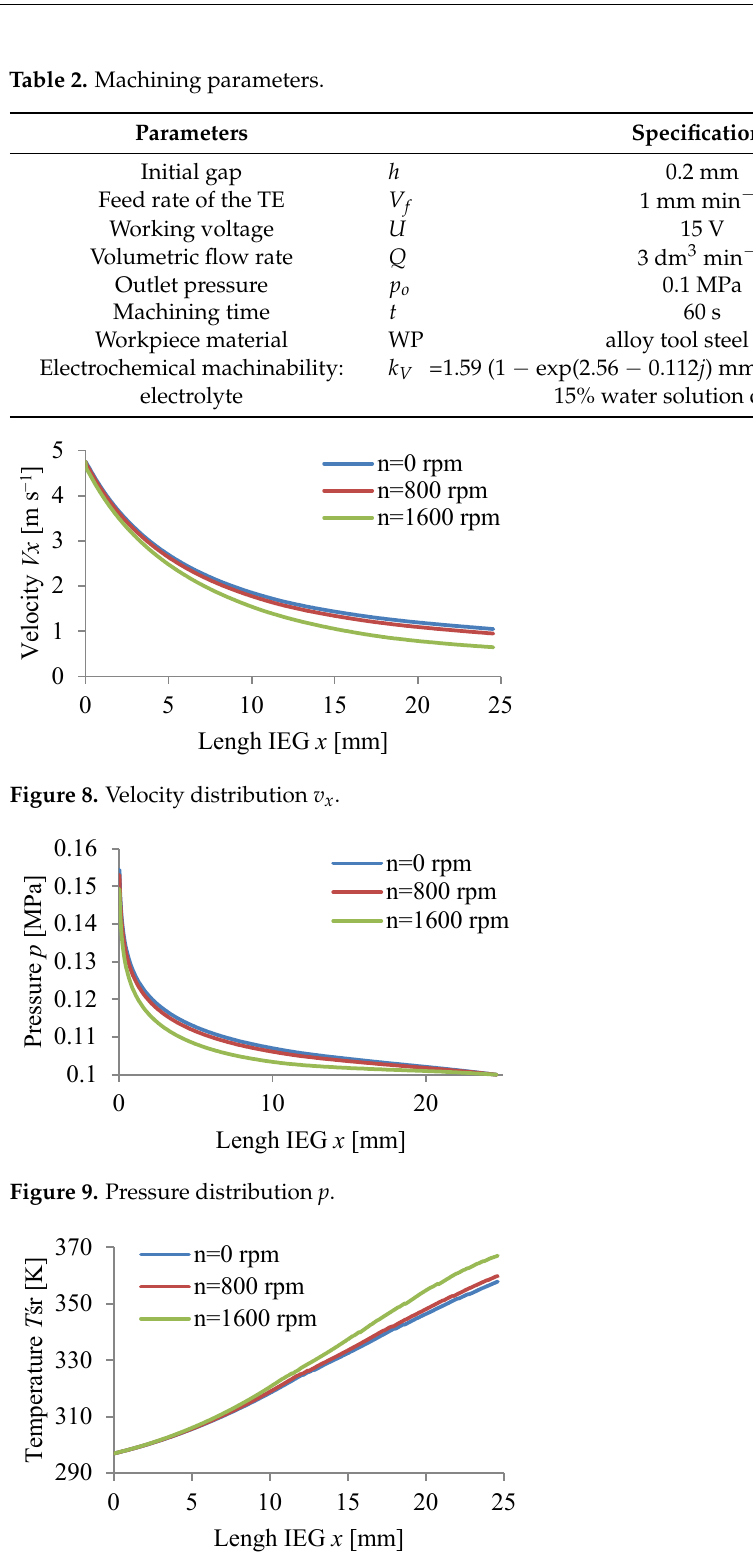
Figure 11. Current density distribution 𝑗 . Figure 12. Void fraction distribution β . Figure 13. Local gap size distribution h.